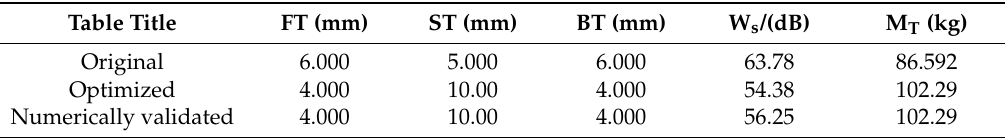
Table 4. Massless constrained optimization results.